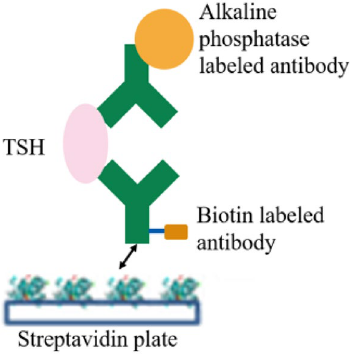
Figure 3. The architecture of the streptavidin–biotin sandwich CLEIA for TSH. Streptavidin images: BIOVIA, Dassault Systèmes, Discovery Studio Visualizer version 19.1(https:// www. 3ds. com/ produ cts- servi ces/ biovia/ produ cts).